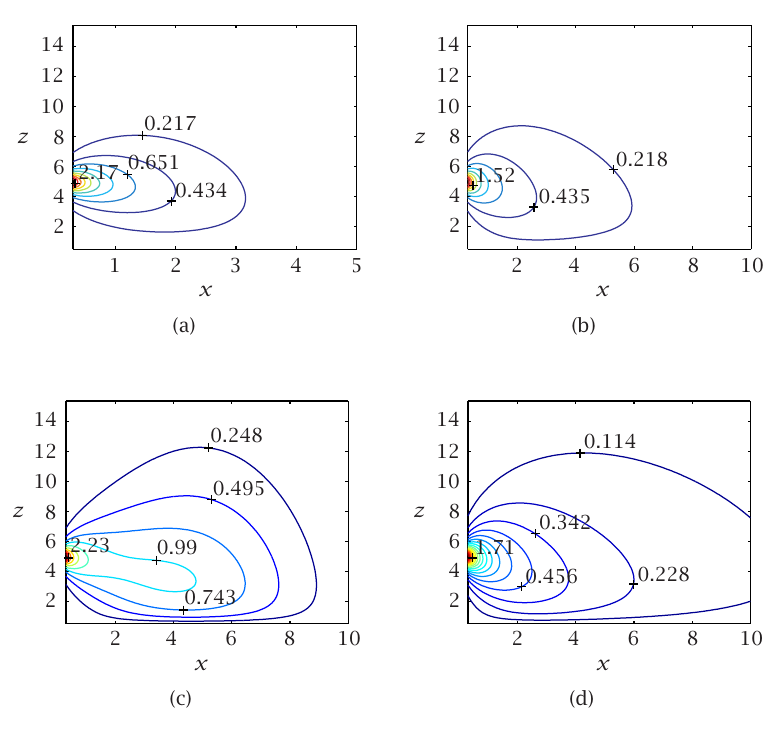
Figure 6.1 . The isolines of the concentration of the point source